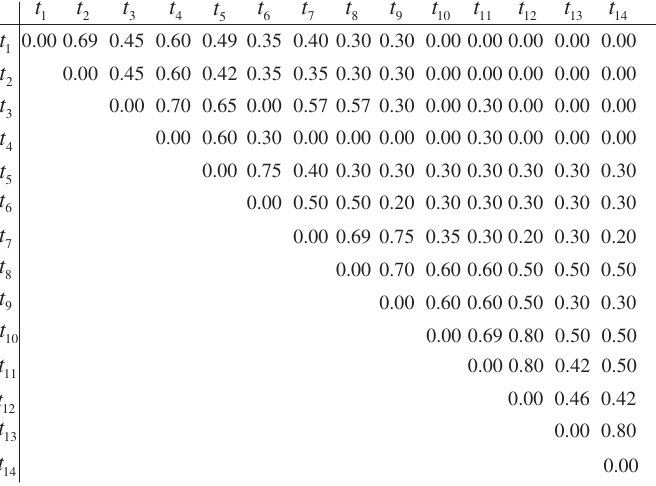
Figure 7: The Comprehensive Correlation Degree Among Tasks.